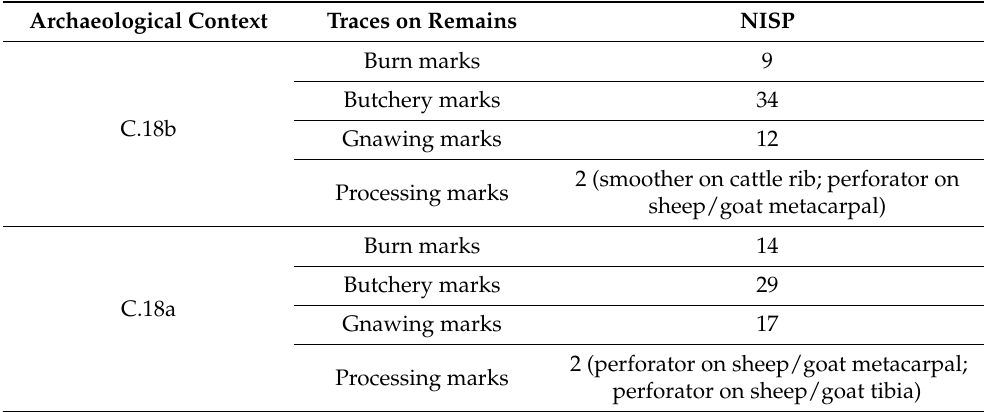
Table 3. Traces identified on mammal remains (NISP = number of identified specimens).